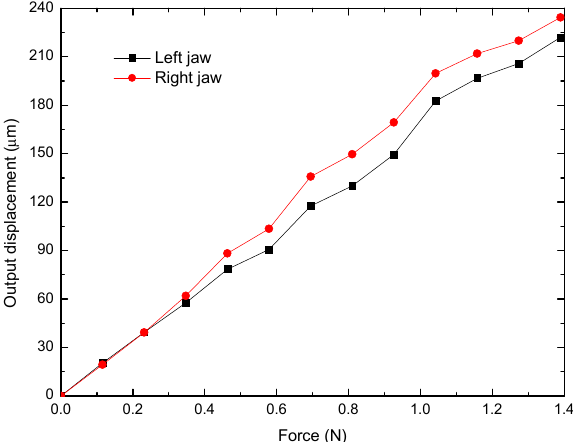
Figure 16. Output displacement of the jaws against the input force.